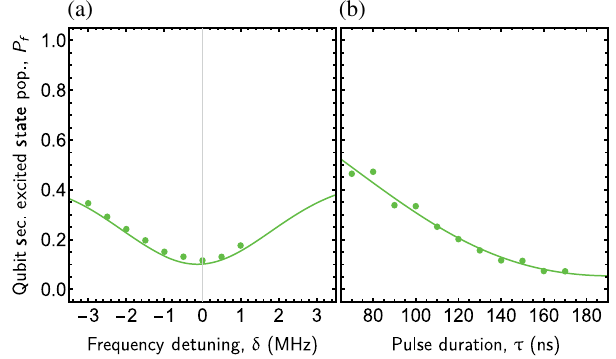
FIG. 14. (a),(b) Second excited state population P after f preparing the gate qubit in the second excited state and applying a modulated flux pulse with a square envelope and a fixed (normalized) amplitude of A ¼ 1 . (a) Fixed pulse duration τ ¼ 170 ns, plotted vs flux pulse frequency detuning δ from the j f 0 i ↔ j e 1 i transition. The solid line is a Gaussian fit to the data. (b) On resonance δ ¼ 0 , plotted vs flux pulse duration τ . The solid line is a fit to the data based on a driven two-level = 2 π ¼ 2 . 1 system decaying at a rate κ G